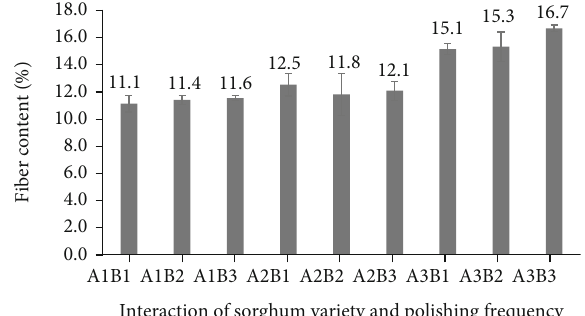
Figure 6: Dietary fi bre content of three polished sorghum varieties at di ff erent polishing frequencies.